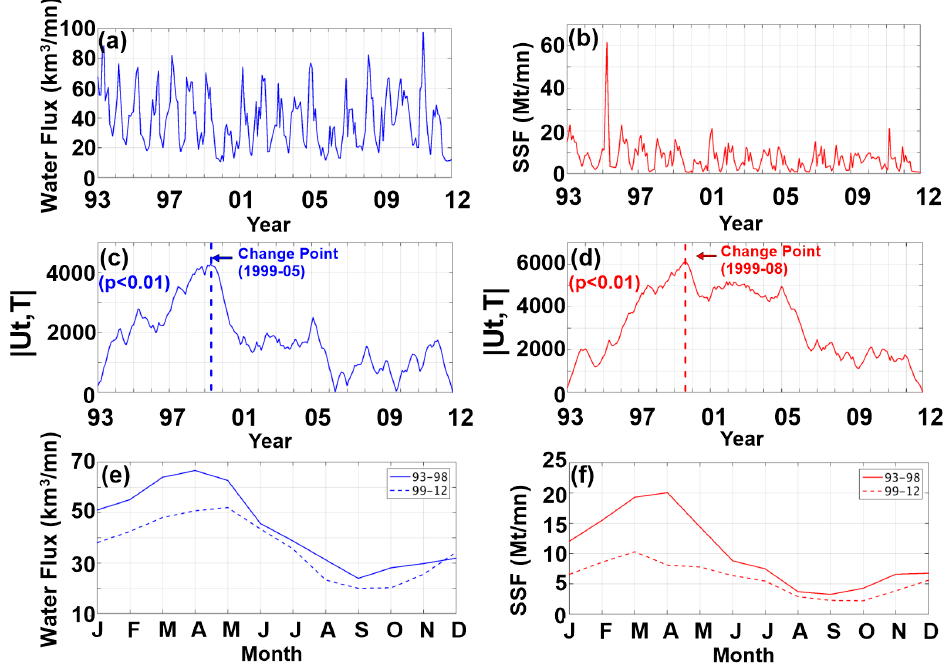
Figure 15. The Mississippi River monthly water discharge ( a ) and suspended sediment flux (SSF)( b ) from 1993 to 2012. ( c , d ) represent Pettitt’s test for detecting a change in water discharge and SSF, respectively. ( e , f ) show multi-year monthly mean water discharge and SSF before (1993–1998; solid line) and after (1999–2012; dotted line) the change point. Water 2019 , 11 , x FOR PEER REVIEW